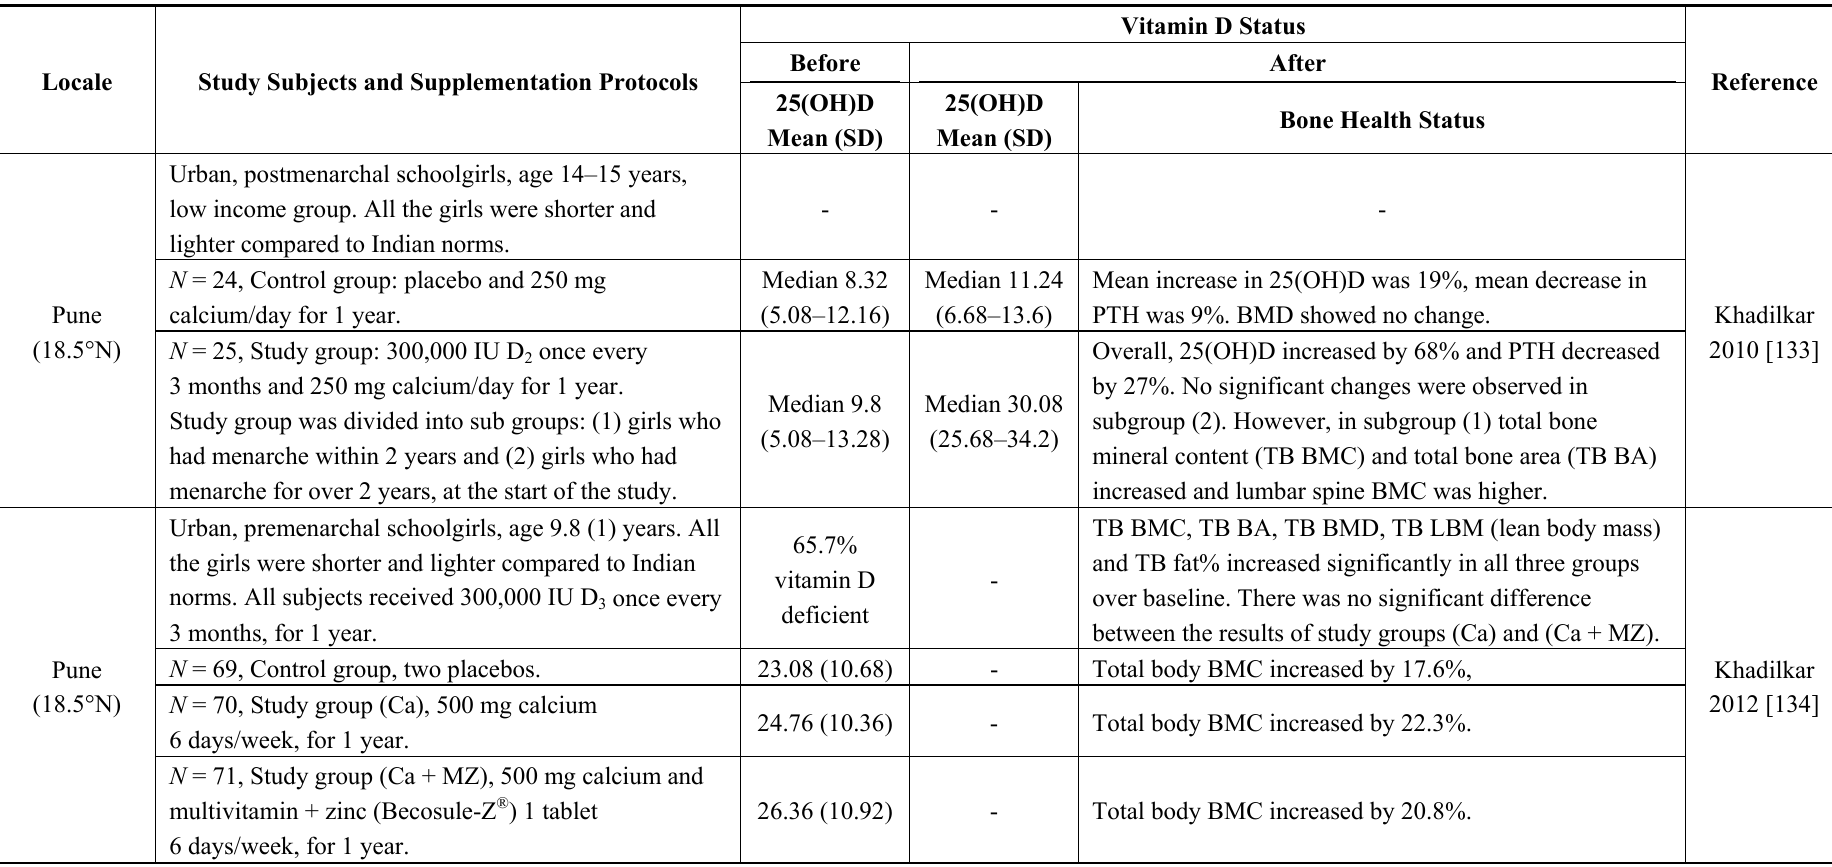
Table 4. Vitamin D supplementation studies reporting improved bone health post-intervention, in ostensibly healthy Indians (adolescents and adults). All 25(OH)D values have been shown in ng/mL. To convert from nM to ng/mL, nM values were divided by (2.5). Vitamin